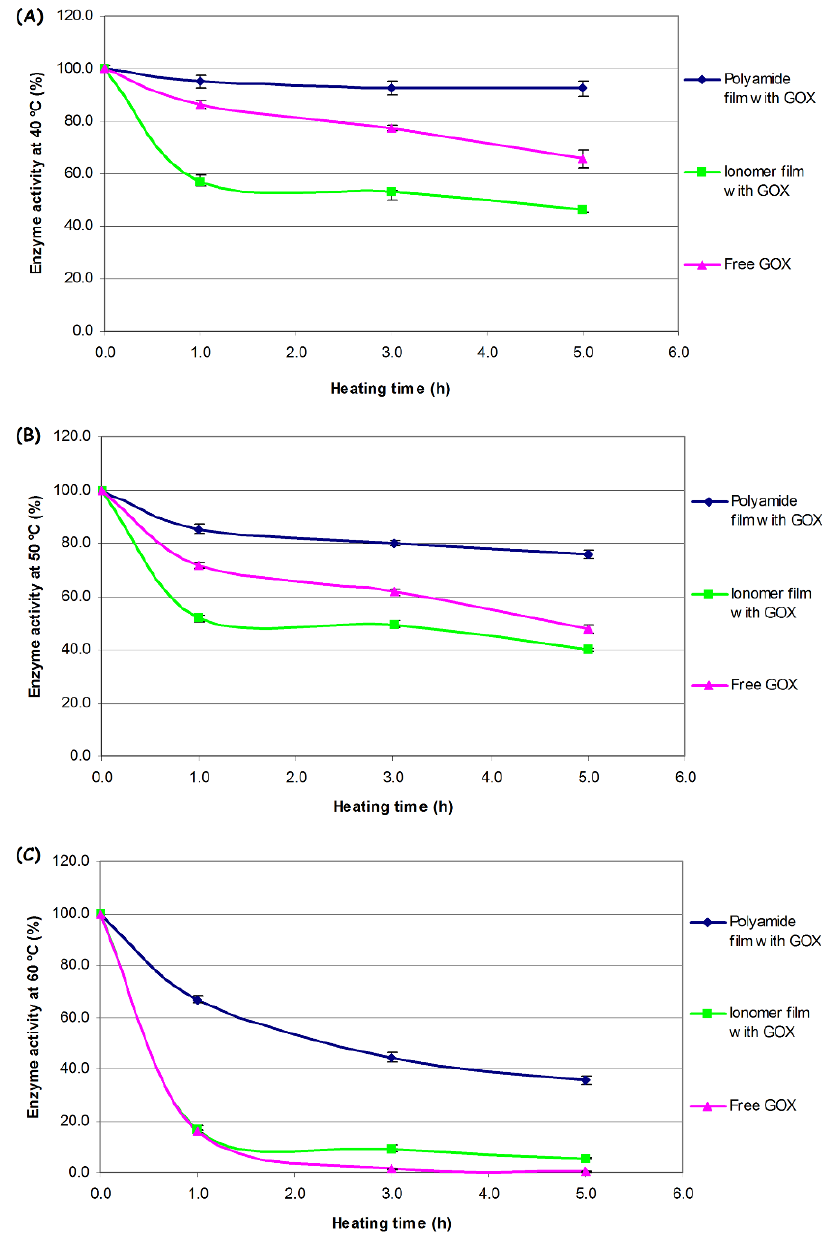
Figure 4. Activity of immobilized and free GOX during heating at 40°C (A), 50°C (B) and 60°C